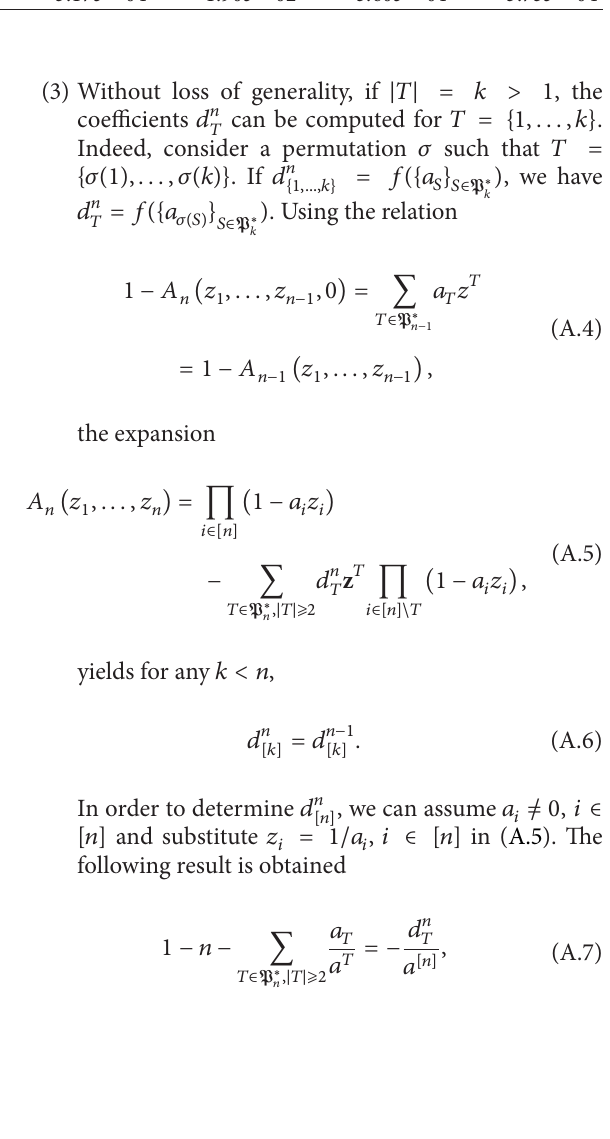
Table 4: Simulation results for the estimation of 𝑃 2 using 2 or 3 images, obtained from 1000 Monte-Carlo runs (matrix Γ 8 ). 𝑛 2 images MLE 3 images MLE Bias std MSE avar Bias